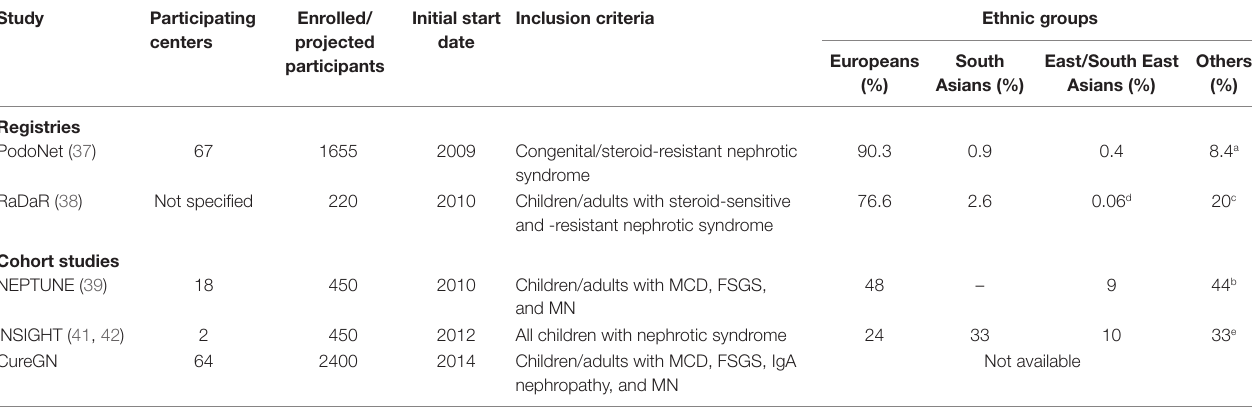
TABLe 1 | Distribution of ethnic groups in ongoing glomerular disease registries and prospective studies.